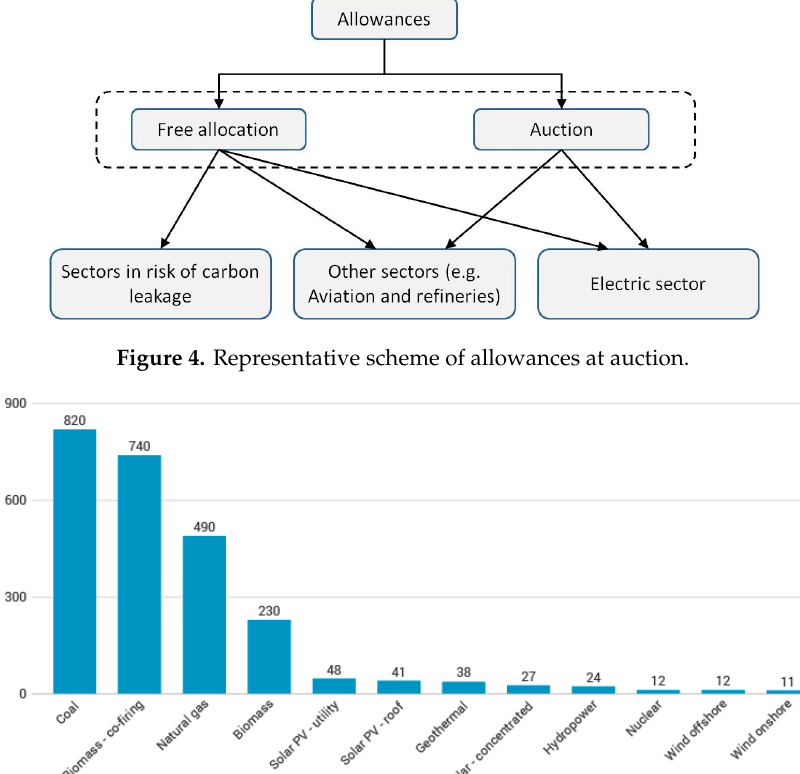
Figure 5. CO 2 emissions directly (fuel combustion) and indirectly (plant manufacturing, maintenance and fuel supply process) in the production of electricity [21].